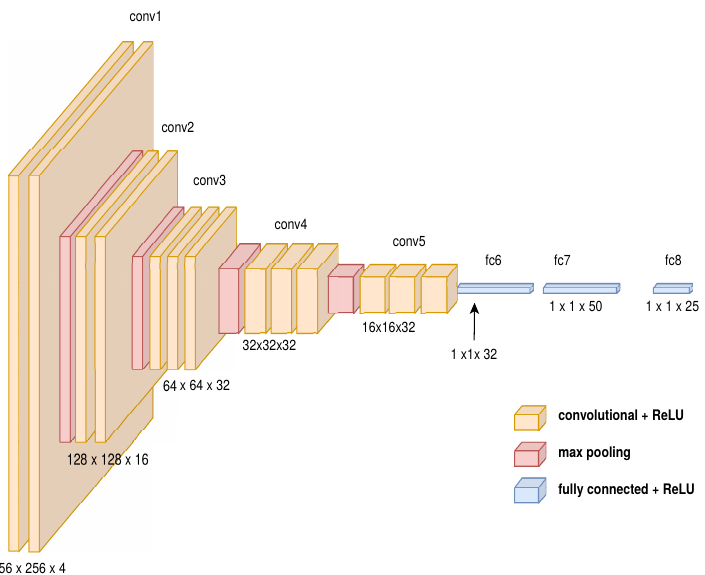
Figure 19. Convolutional model’s features that generate the characteristic vector employing the transfer-learning